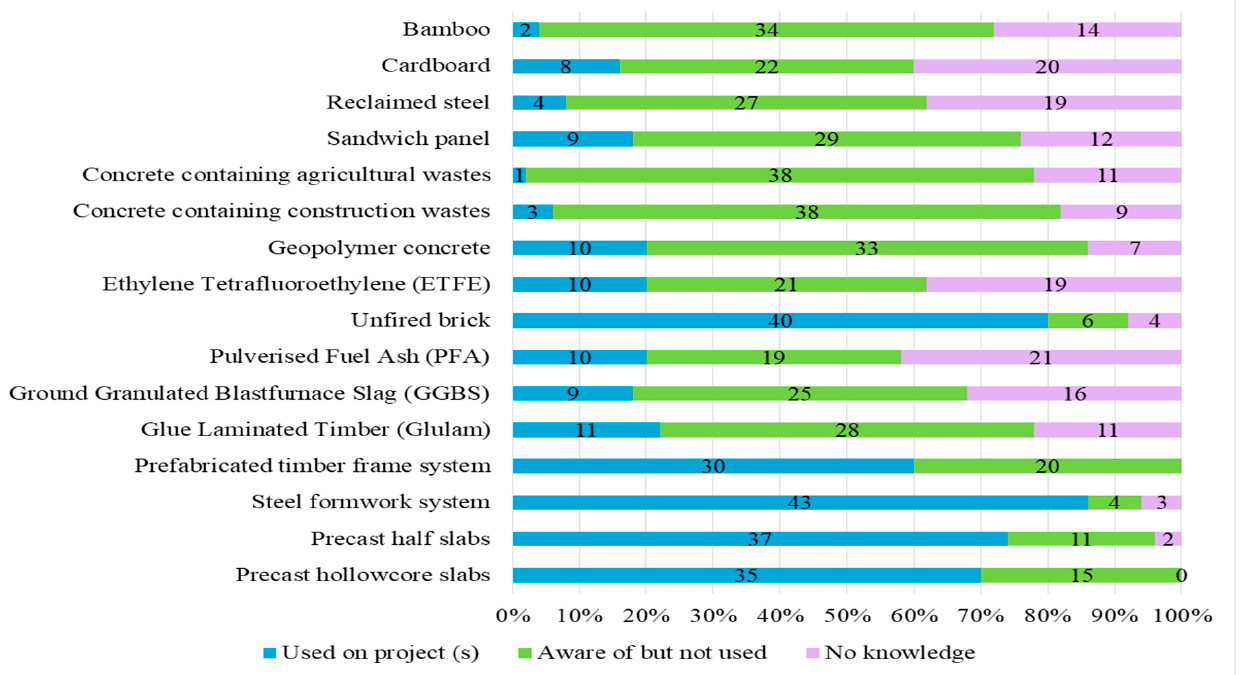
Figure 1. Respondents’ knowledge of alternative materials.